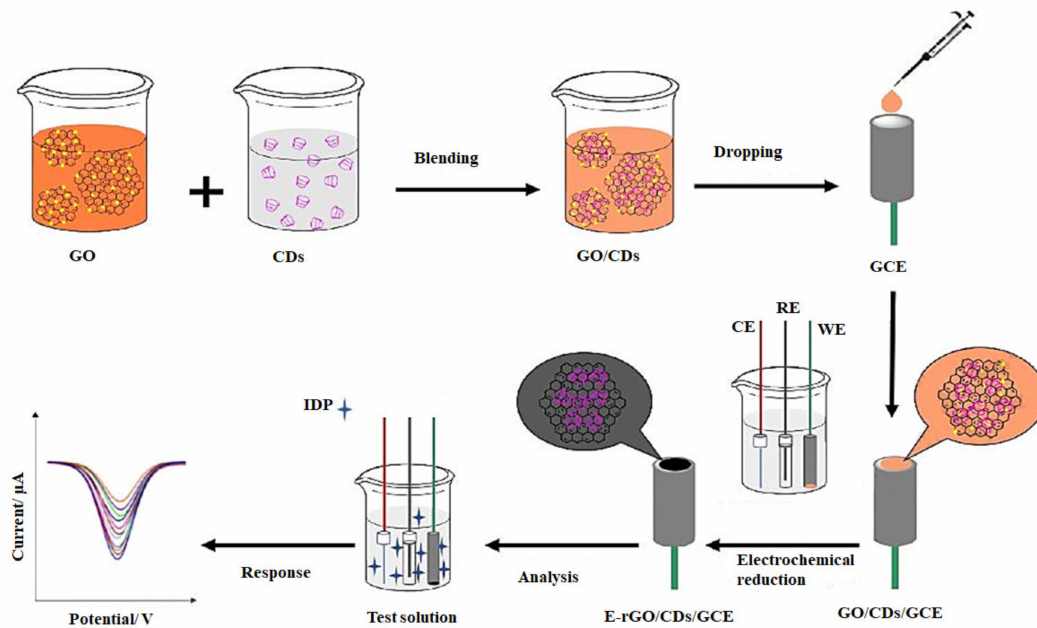
Figure 5. Schematic diagram demonstrating the preparation of food detection system containing electrochemically reduced graphene oxide/cyclodextrin modified glassy carbon electrode (E-rGO/CDs/GCE) to quantify the amount of imidacloprid (IDP) in test solution [142]. CE—counter electrode, RE—reference electrode, and WE—working